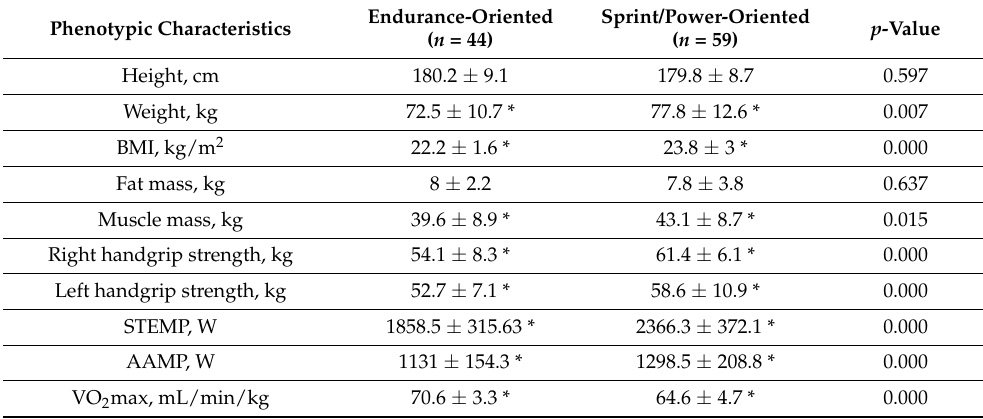
Table 2. Phenotypic characteristics of Lithuanian elite athlete